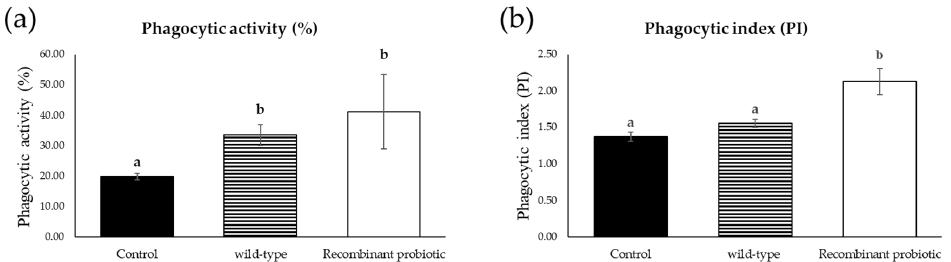
Figure 8. Effect of dietary probiotic supplementation on phagocytic activity and phagocytic index of phagocytic cells in PBLs (n = 5). ( a ) Phagocytic activity (%); ( b ) phagocytic index (PI). Bars with different letters indicate significant differences ( p < 0.05).